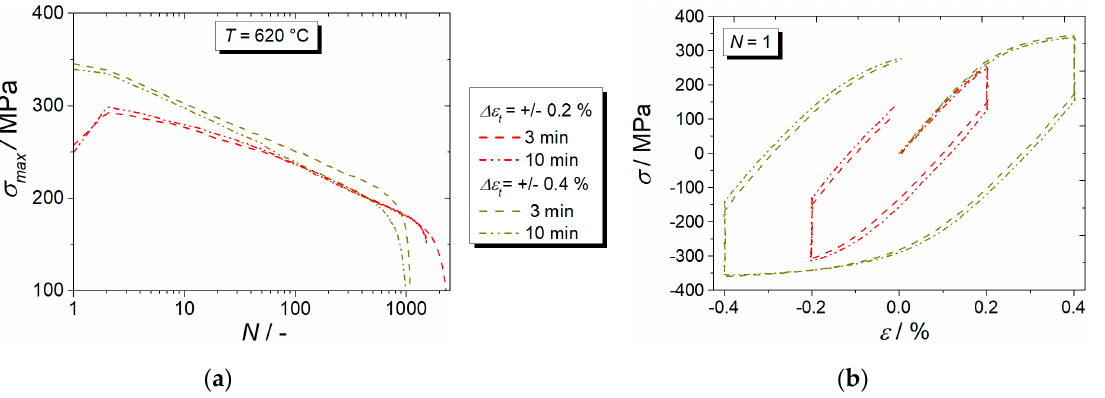
Figure 14. Cyclic softening curves ( a ) and hysteresis loops of the first cycle ( b ) for selected RF-tests with different hold times. Table 9. Softening ratio and lifetime for the RF-tests at different hold times and total strain ranges.